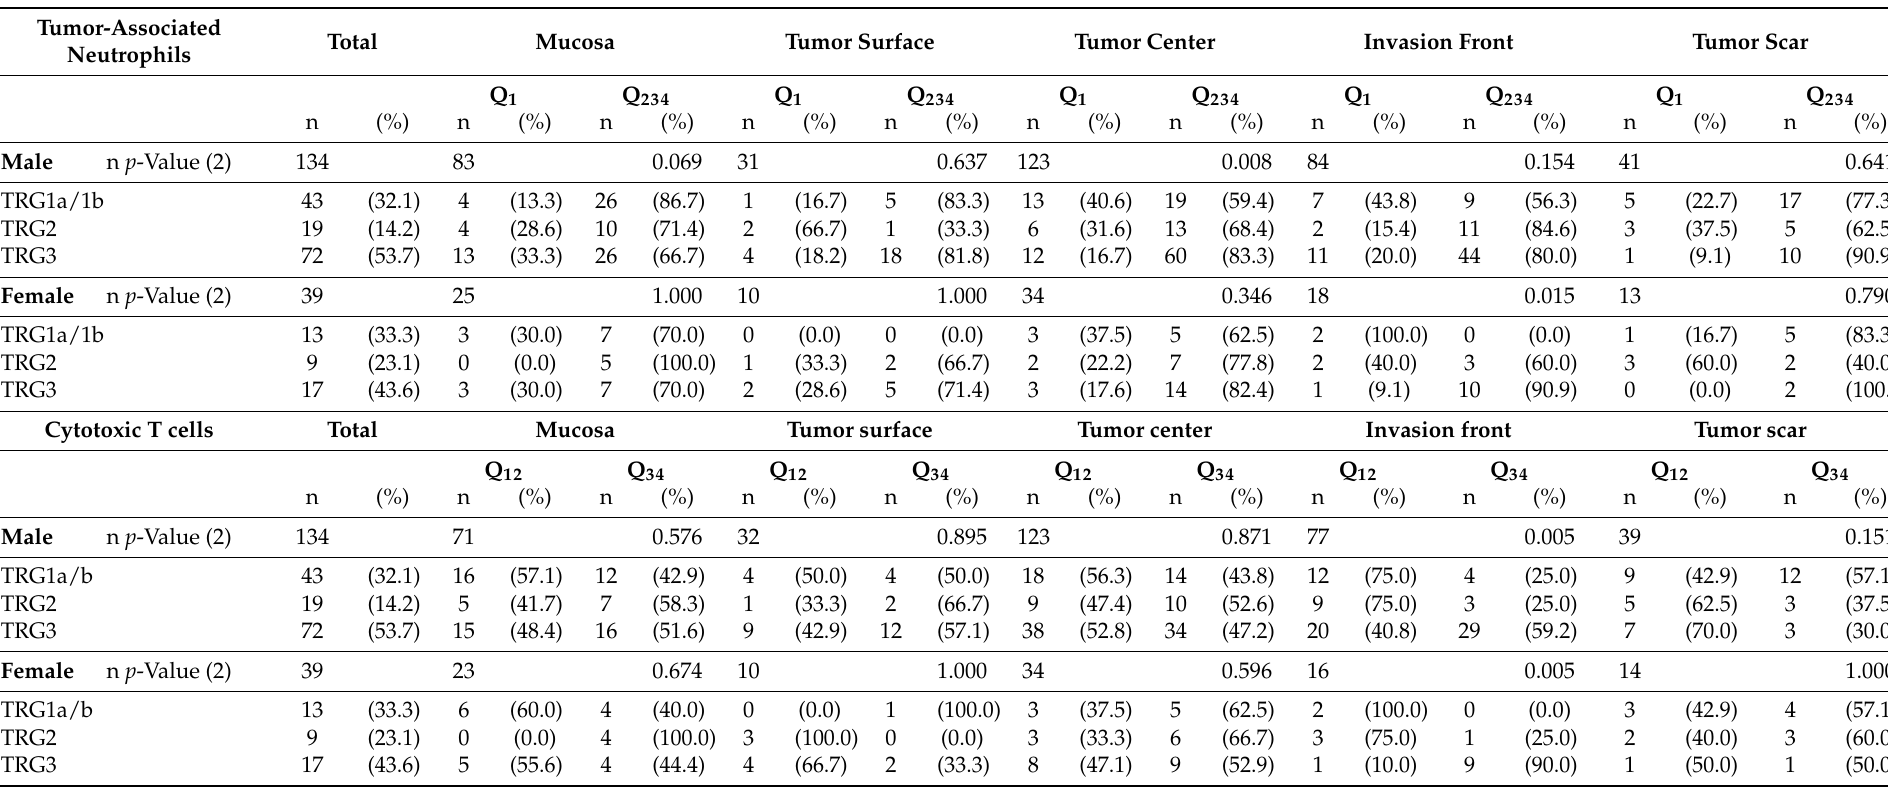
Table 4. Correlation of the densities of tumor-associated neutrophils and cytotoxic T cells divided into men and women, with tumor regression grade (TRG) according to Becker. (2) Kendall’s tau